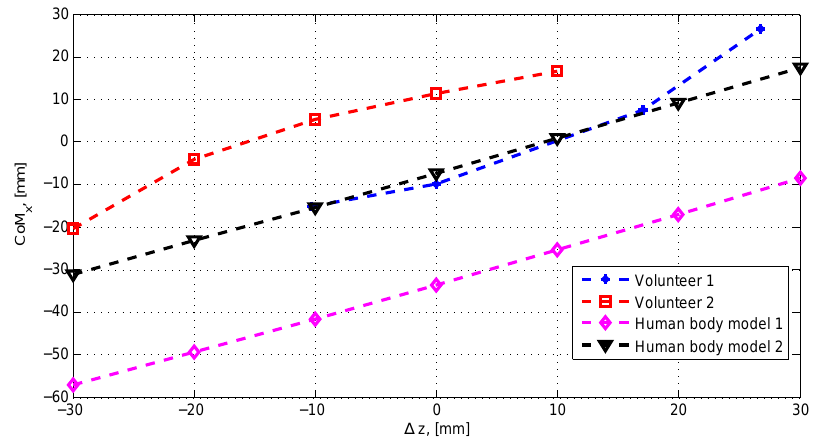
Figure 19. Experiment 2: Shift of the CoM along the x -axis ( CoM x ) depending on a force plate height difference ∆ z